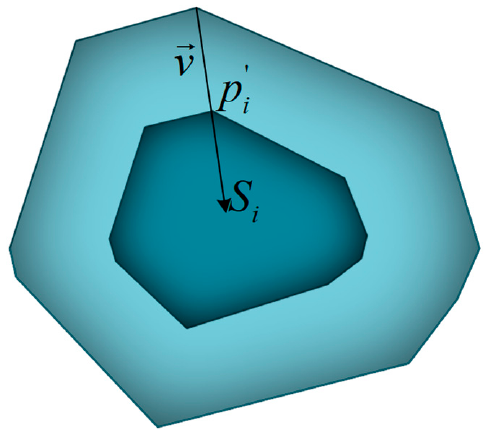
Figure 2. Schematic diagram for a single aggregate.